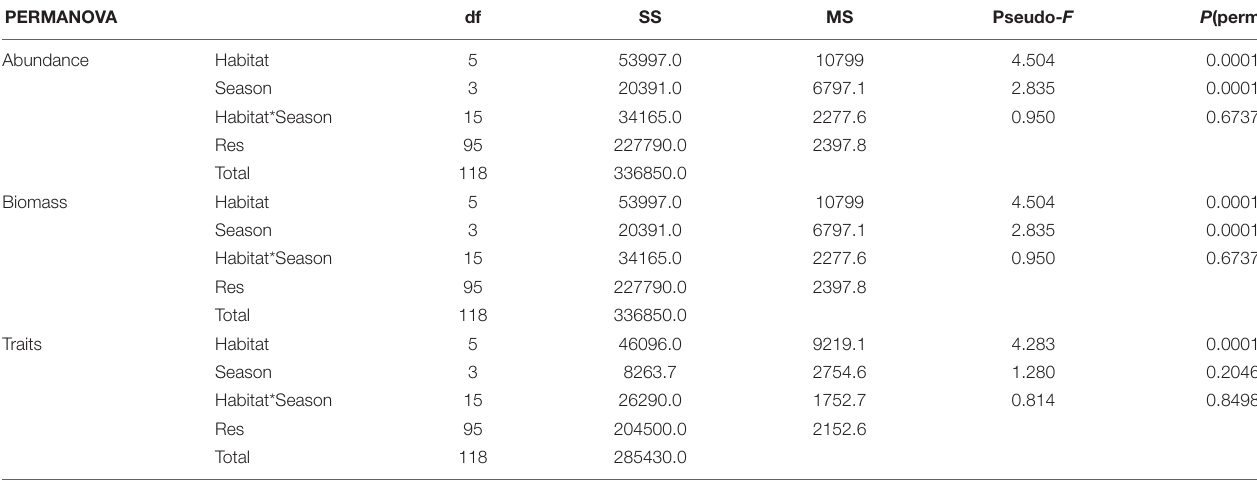
TABLE 3 | Two-way PERMANOVA testing differences in benthic community abundance, biomass and traits between the four seasons ( n = 5) and the six habitats ( n = 5). PERMANOVA df SS MS Pseudo- F P (perm) Abundance